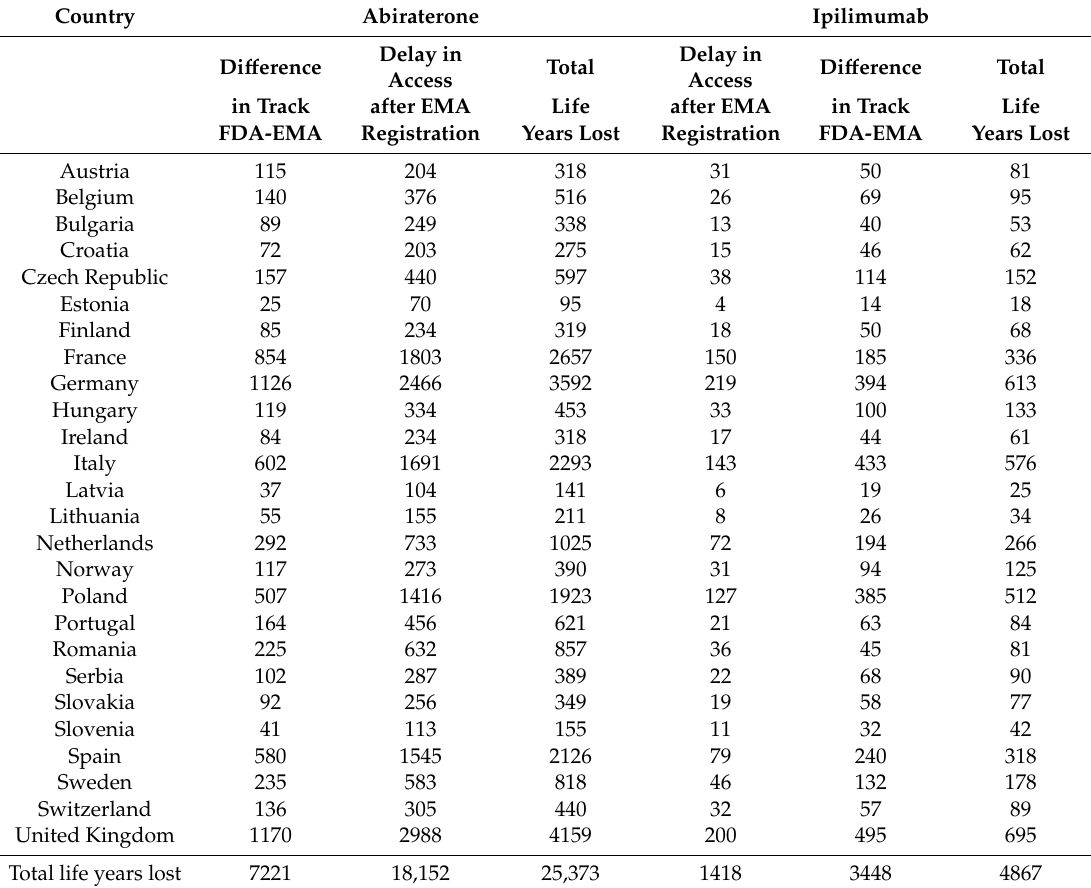
Table 2. Potential life years lost due to delay in access in abiraterone and ipilimumab across Europe. Country Abiraterone Ipilimumab Delay in Di ff erence